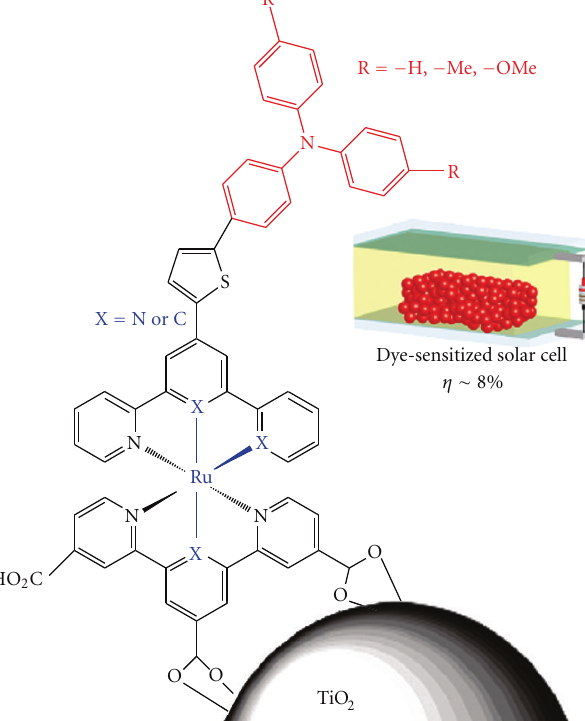
Figure 35: Bistridentate cyclometalated Ru(II) complexes in DSSC (taken from